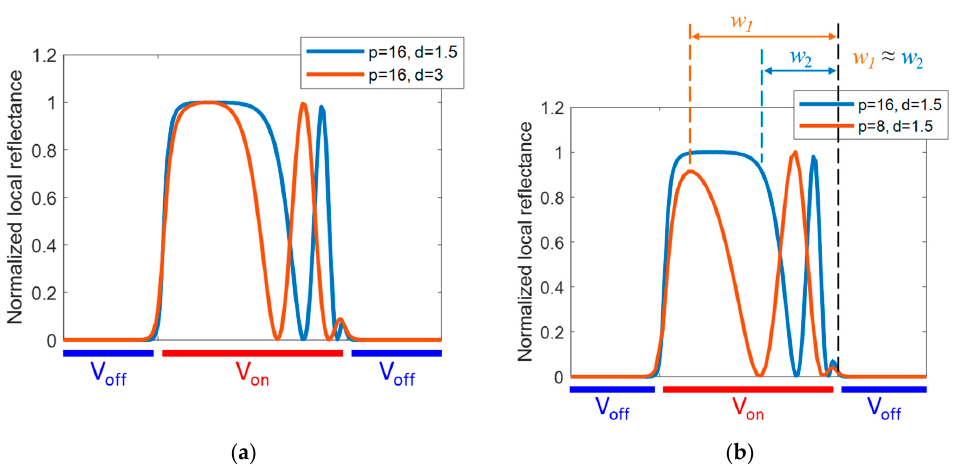
Figure 6. The fringing field effect (FFE) of a VA cell: ( a ) cell gap effect; ( b ) pixel pitch effect. p , d , and w stand for pixel pitch, cell gap, and FFE border width, respectively (unit: μ m).